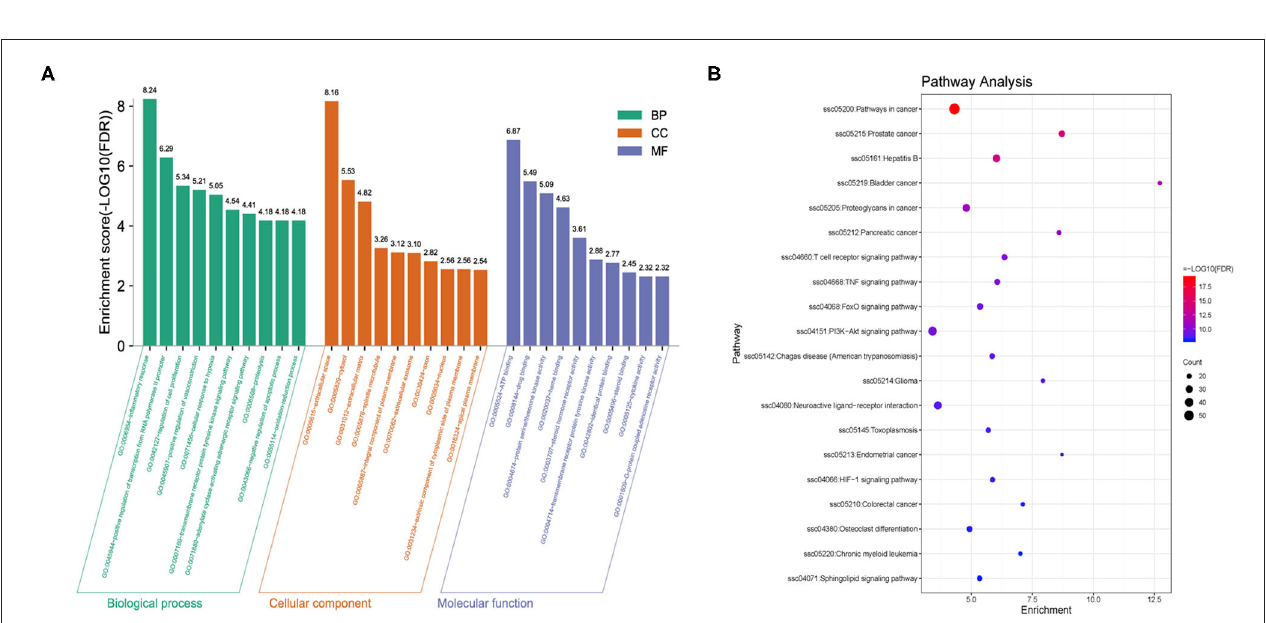
FIGURE 5 | Gene Ontology (GO) and Kyoto Encyclopedia of Genes and Genomes (KEGG) analyses of targets. (A) GO analysis of targets: X-axis represents GO terms, and Y-axis indicates the enrichment score [adjusted false discovery rate (FDR)] in that term. (B) KEGG analysis of targets: Dot plot showed the top 20 KEGG pathways with adjusted FDR. The color scale indicates the adjusted FDR, and the dot size represents the gene count in each term.